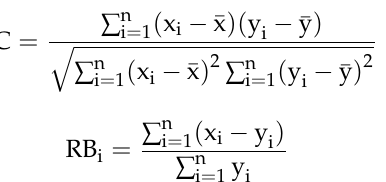
Figure 7. Flow diagram of extracting dam locations .